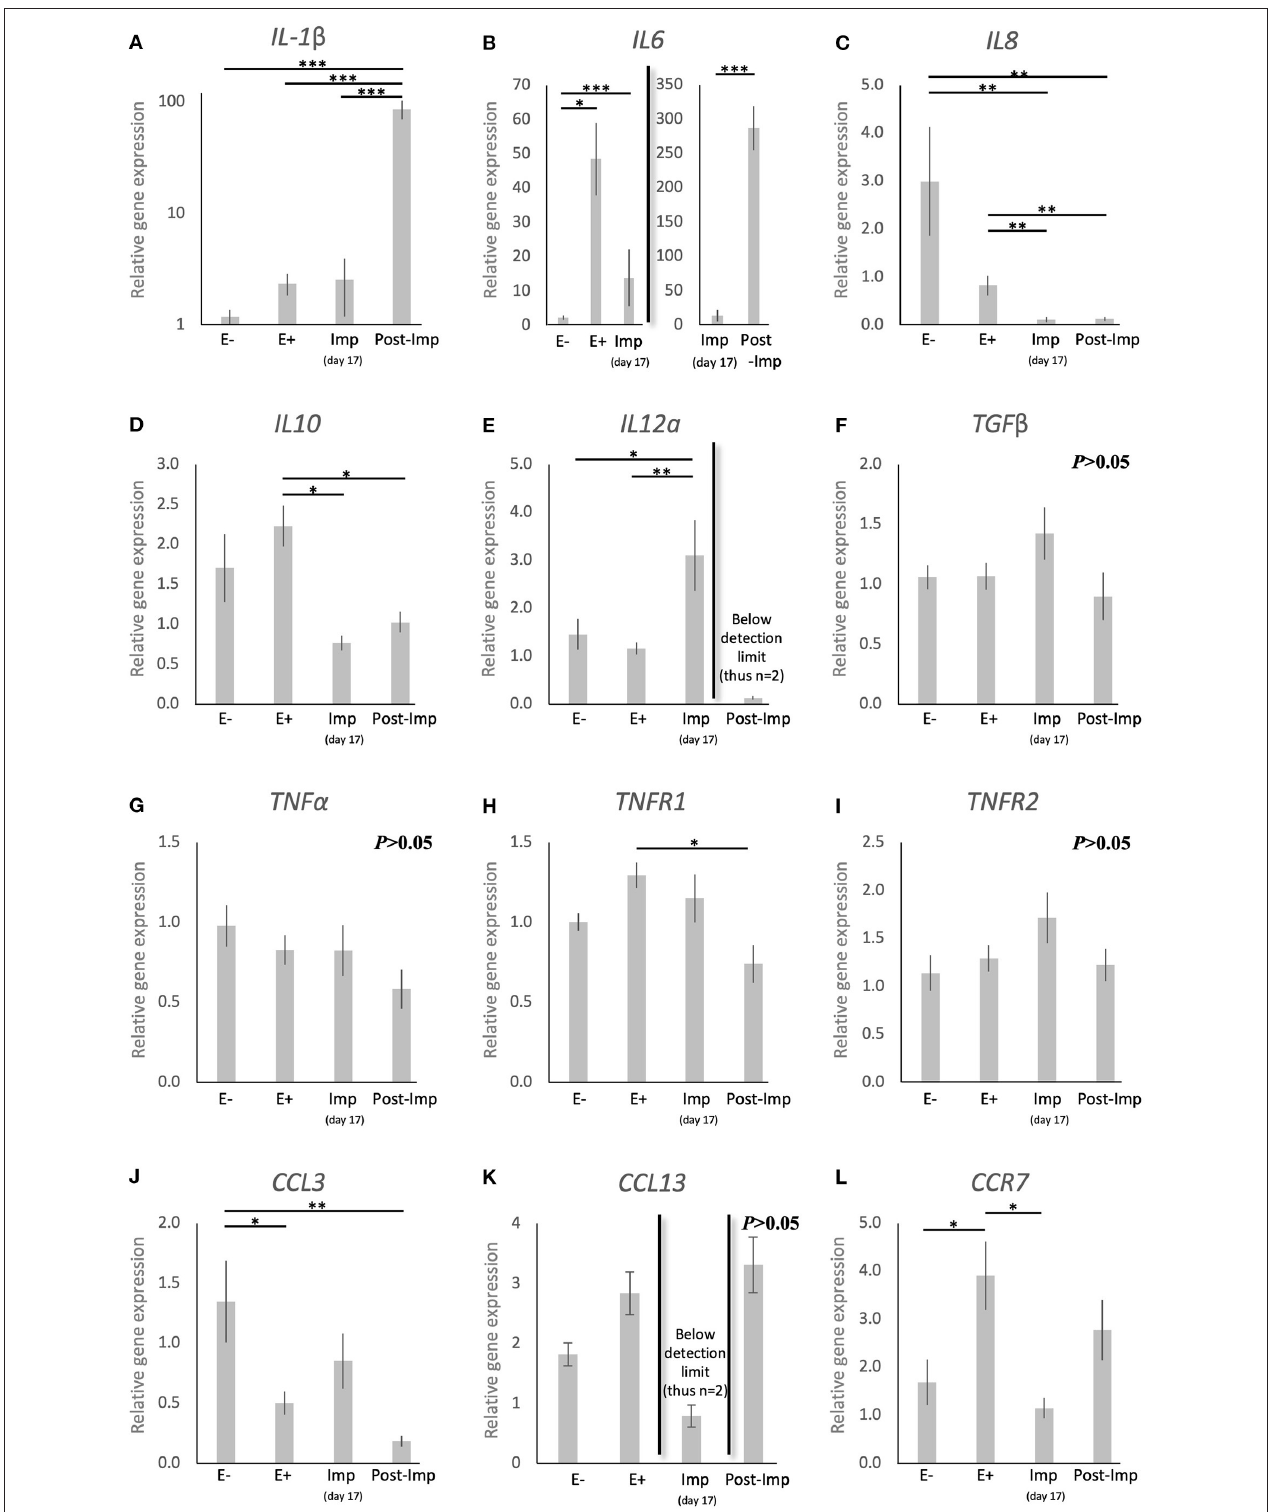
FIGURE 3 | Relative gene expression of selected cytokines in the canine uterus. (A–L) Relative gene expression as determined by semi-quantitative real time (TaqMan) PCR (mean ± SEM). One-way ANOVA was applied, revealing: P < 0.0001 for IL1 β , P < 0.0001 for IL6 , P < 0.0001 for IL8 , P = 0.01 for IL10 , P = 0.02 for IL12a , P = 0.16 for TGF β , P = 0.19 for TNF α , P = 0.02 for TNFR1 , P = 0.19 for TNFR2 , P = 0.006 for CCL3 , P = 0.083 for CCL13 and P = 0.01 for CCR7 . In the case of P < 0.05, this was followed by a Tukey-Kramer multiple comparisons post-test. Bars with asterisks differ at: * P < 0.05, ** P < 0.01, *** P < 0.001.